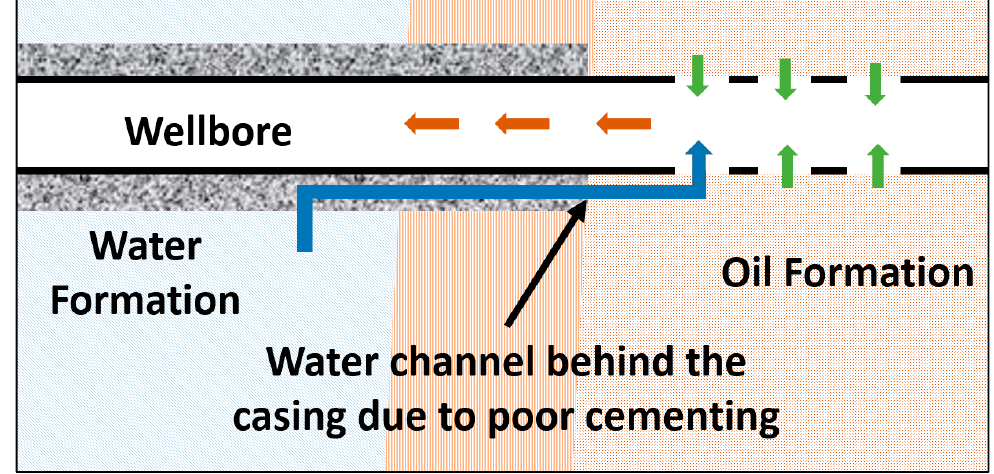
Figure 4. Poor cement behind the casing with a channel connecting water source to the wellbore.